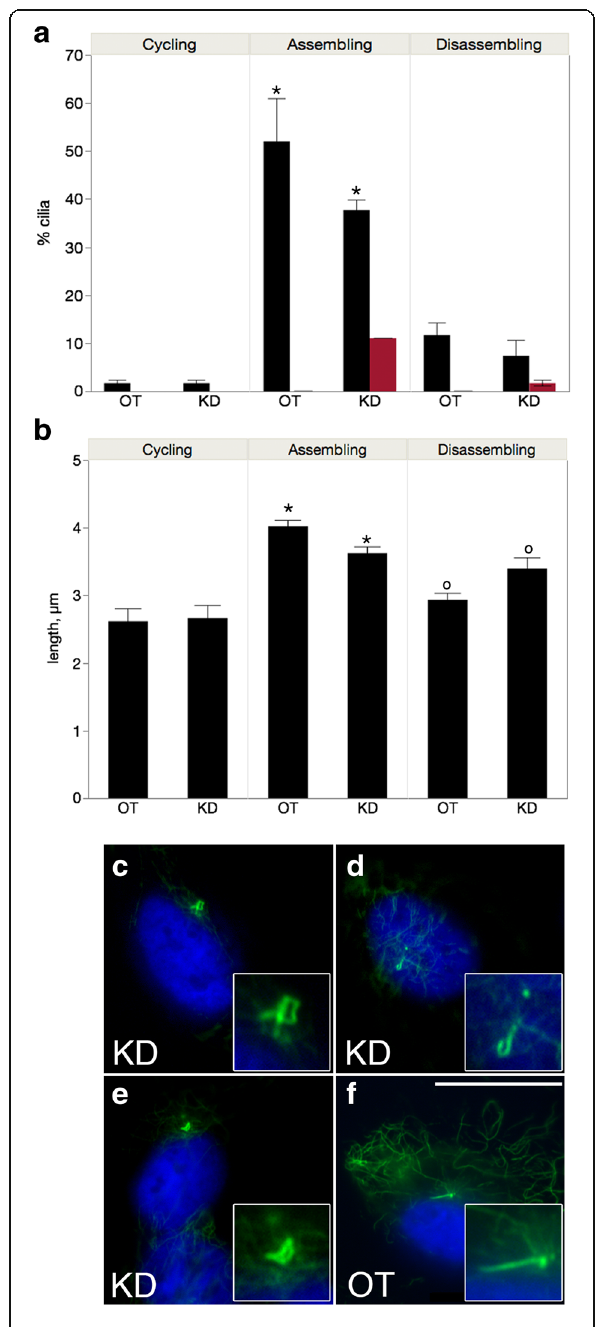
PP1 to the centrosome for interaction with kinases. Nek2 and AurA counteract the effects of R42 overexpression on cilia